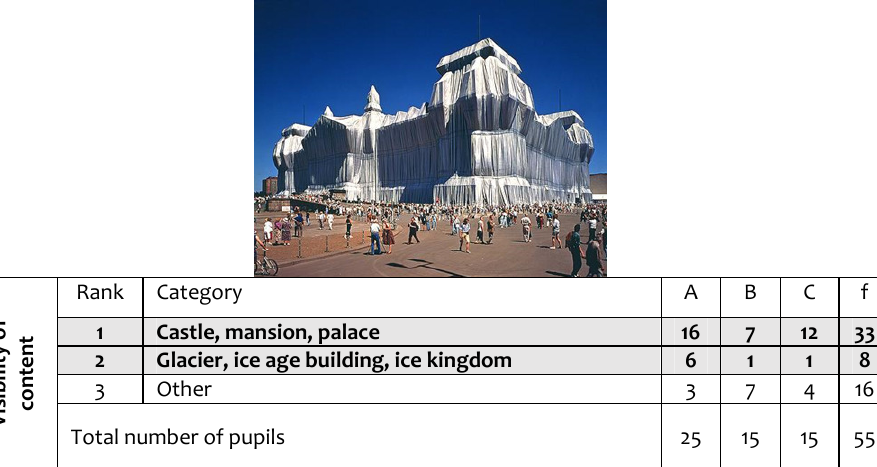
Table 15: Ranking order of categories of answers regarding the recognition of the content of the sixth example (Christo & Janne Cloude, Wrapped Reichstag, Berlin, 1971 – 1995).